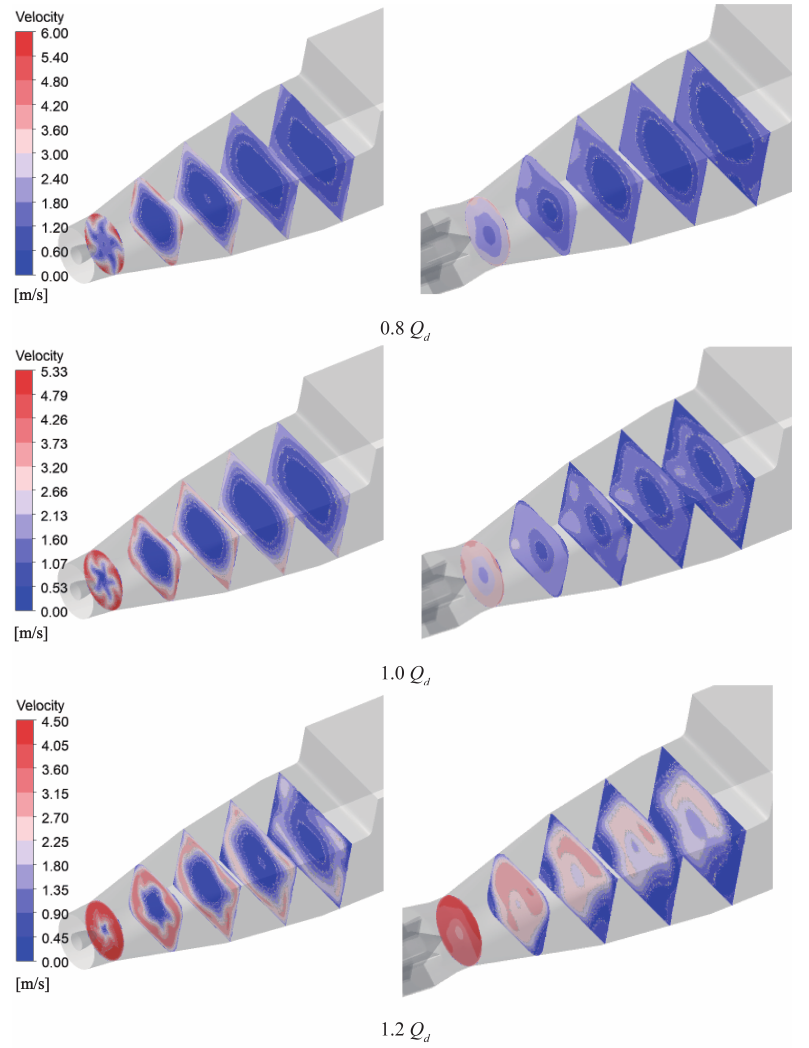
Figure 11. Internal velocity distribution of the outlet flow channel under different flow conditions: ( left ) front-mounted scheme; ( right ) rear-mounted